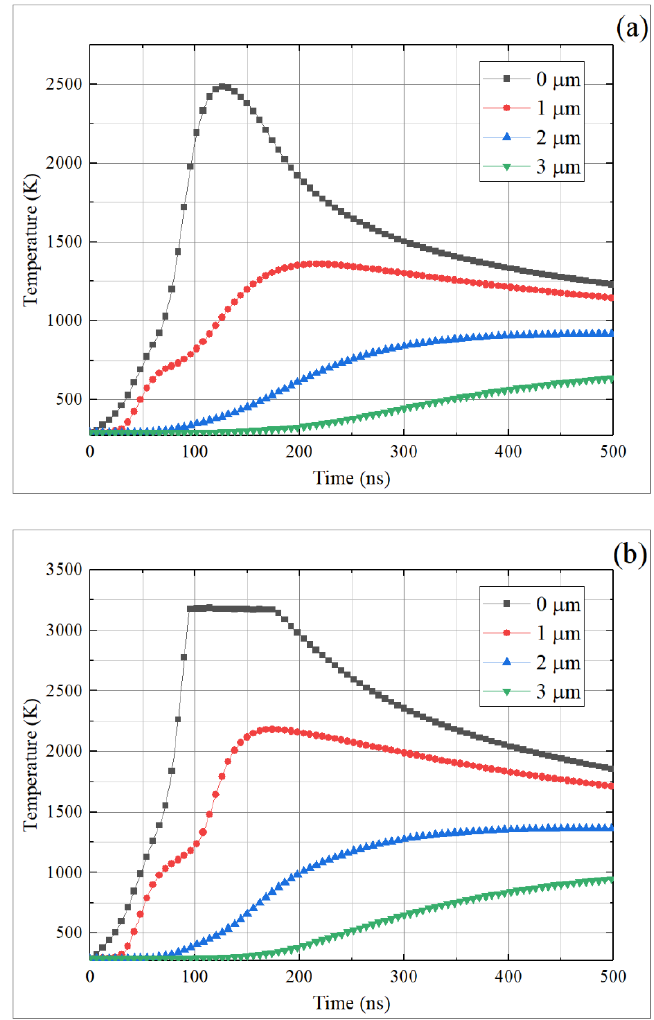
Figure 6. Temperature evolution by IPIB irradiation with current density ( a ) 100 and ( b ) 200 A/cm 2 in IN718 at different depth in the target.